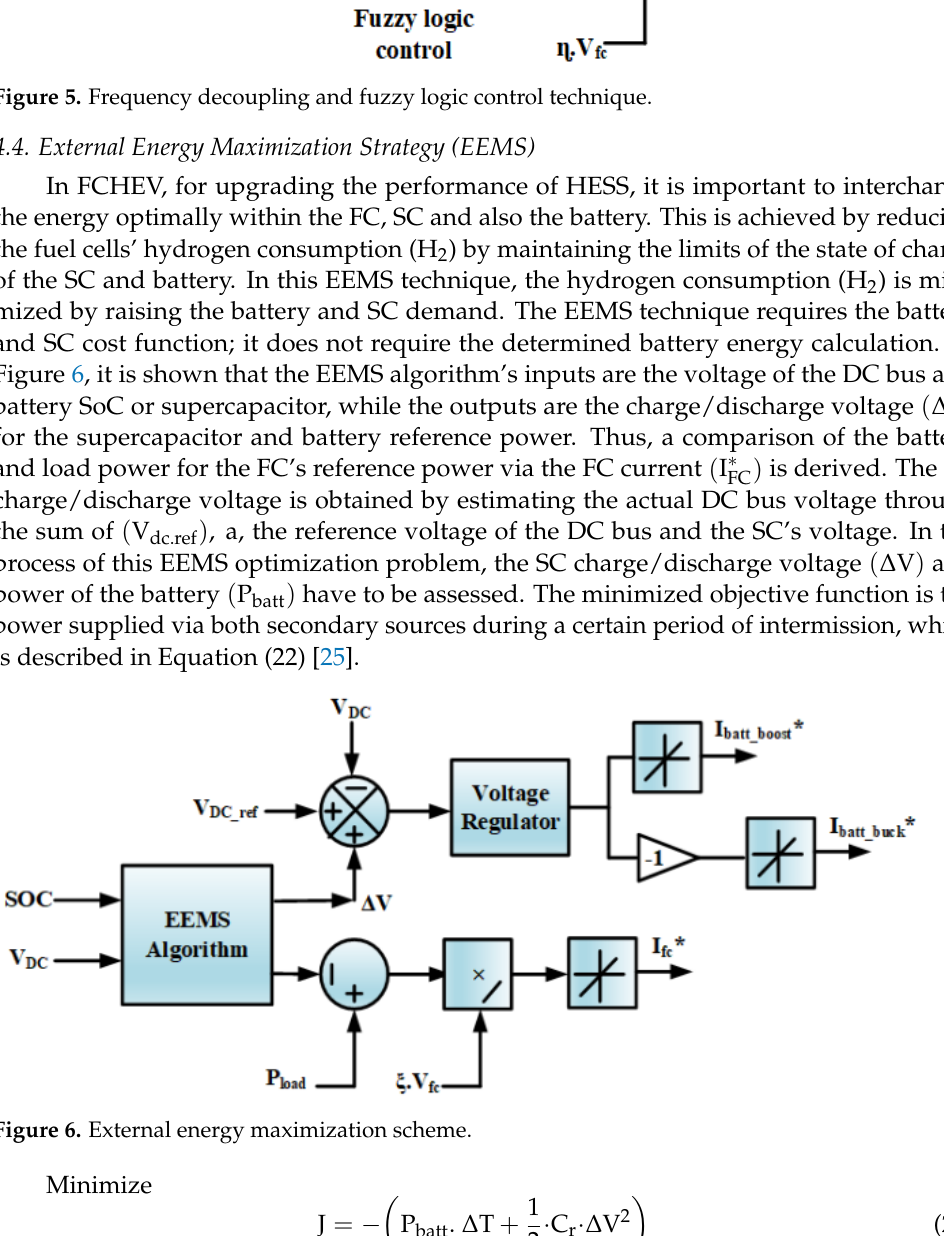
Figure 5. Frequency decoupling and fuzzy logic control technique.